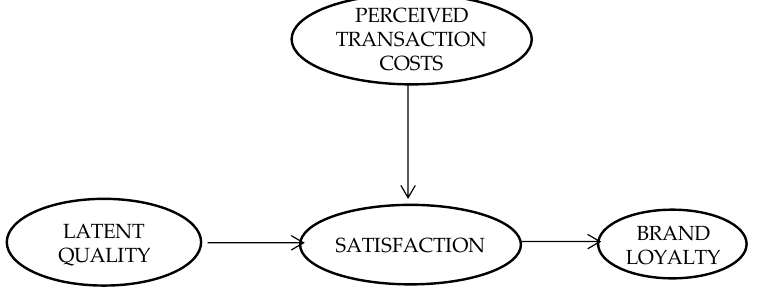
Figure 1. E-TPP structural theoretical model.